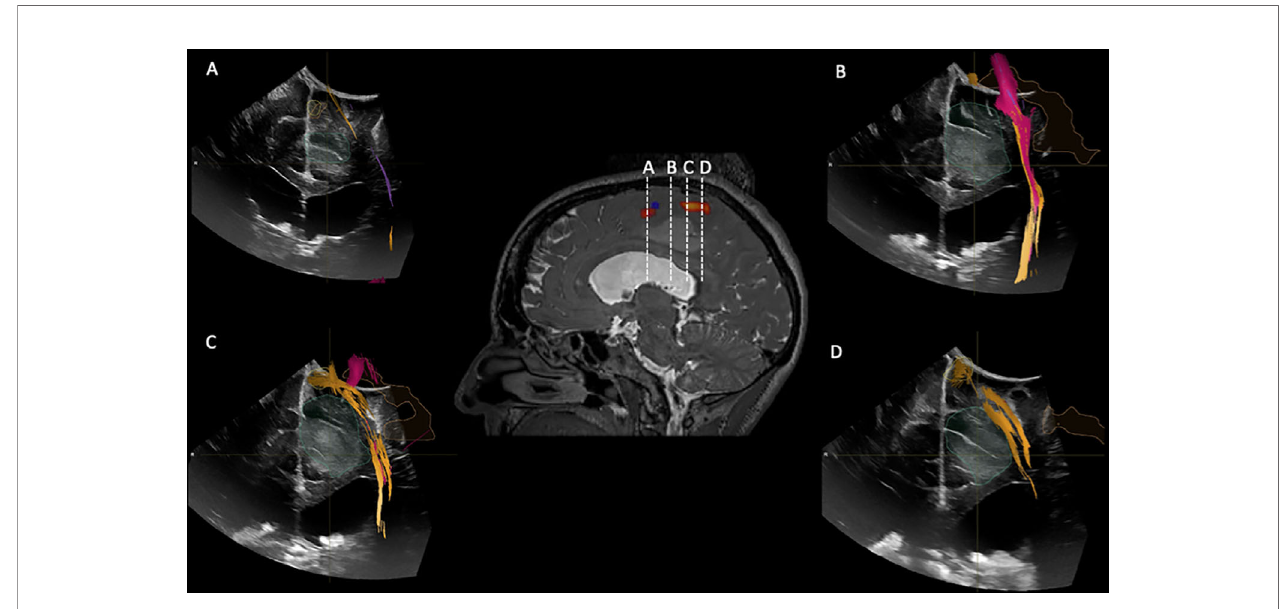
FIGURE 6 | iUS1 in Case 3. Central panel shows a sagittal T2*-weighted imaging with fMRI BOLD activations for lower extremity (red) and upper extremity (blue). (A) Coronal iUS-1 showing the most anterior part of the tumor; (B) coronal iUS-1 showing the only possible surgical corridor that avoids the fMRI BOLD activations areas and Corticospinal Tract (CST); (C) Coronal iUS-1 overlaid with fMRI BOLD activation for lower extremity and CST superior to the tumor; (D) coronal iUS-1 with overlay of CST superior to the